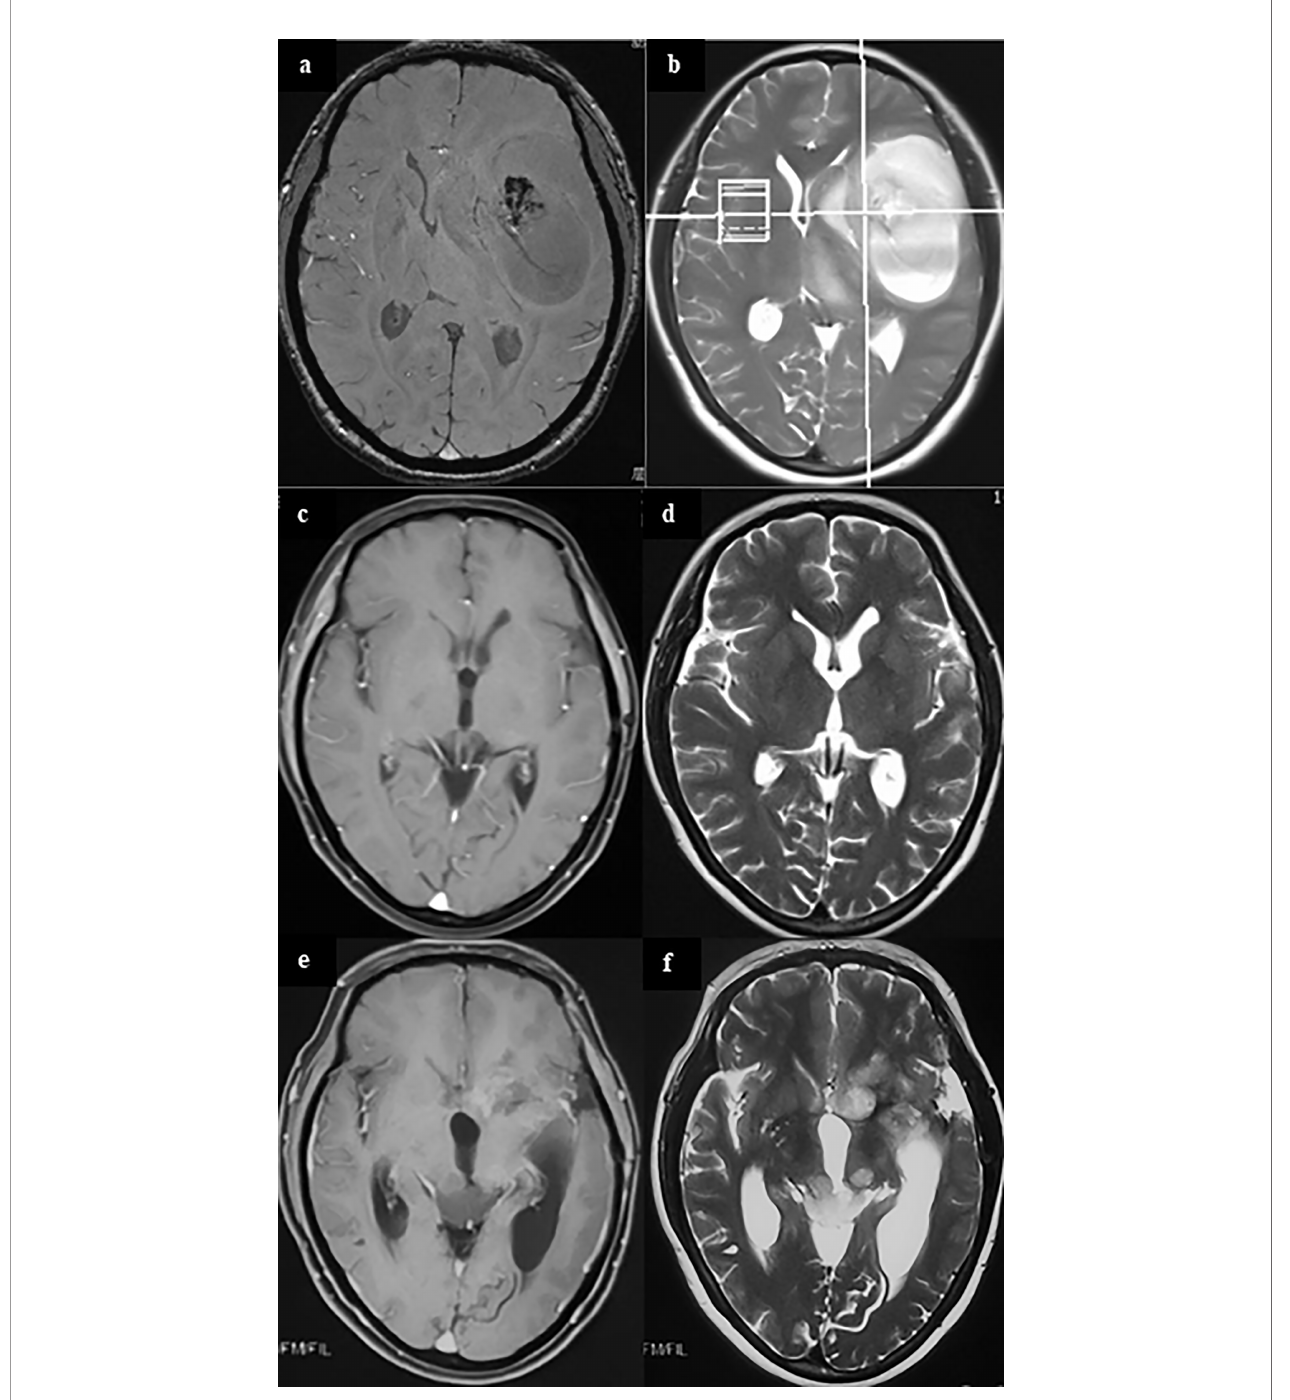
FIGURE 1 | A case of metachronous multicentric glioma. The patient underwent MRI for headache and found a tumor in the left temporal insula (A, B) . She was given partial resection of the tumor. Pathology showed GBM. Local radiation and temozolomide based chemotherapy were given after surgery. The tumor completely regressed in MRI 1 year after surgery (C, D) . However, in follow-up 1.5 years after surgery, it was found that the patient had a recurrent lesion in the left caudate head and insula, and an ectopic lesion in the midbrain tectum (E, F) . On sequential T2 and FLAIR MR images, there was no connection between the lesion in the midbrain tectum and in the right basal ganglia. In addition, cytologic test of CSF and MR of the brain and spinal cord did not fi nd there was any evidence of CSF dissemination. Therefore, the lesion in the midbrain tectum is considered as a metachronous multicentric glioma in contrast with the initial tumor. The patient underwent ventricular-abdominal shunt surgery to relieve hydrocephalus and was given temozolomide chemotherapy again. She is still under follow-up (21 months after tumor resection). (a,c,e, MRI of T1 enhanced signal; b, d, f, MRI of T2 signal).